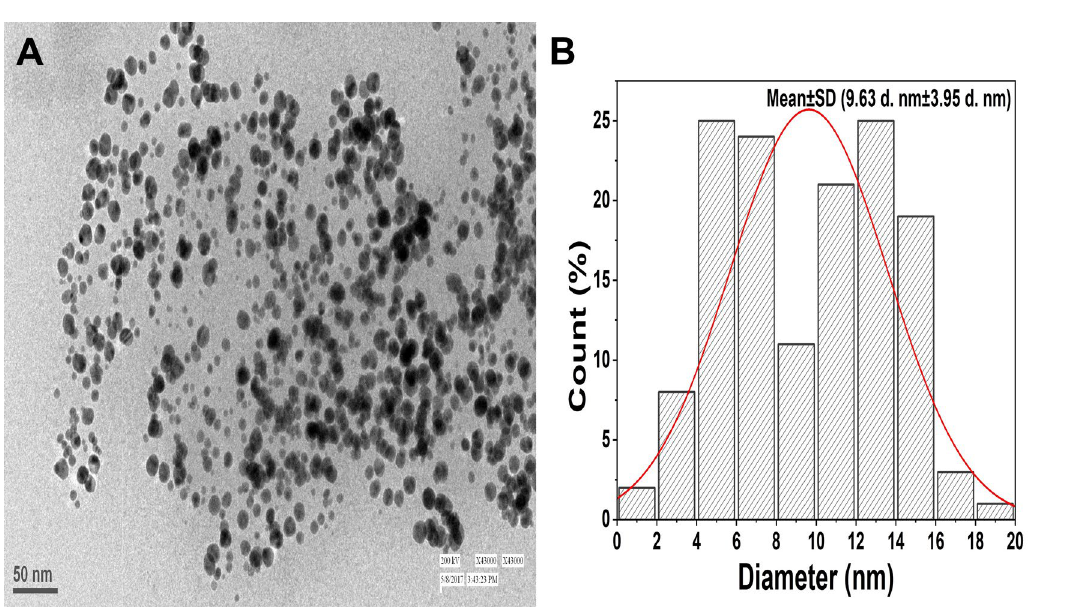
Figure 2. ( A ) TEM micrograph generated for the original sample of the 2 mM Au–Pd BNPs synthesized after the addition of 10% aqueous leaf extract of Citrus limon ; ( B ) Particle size distribution histogram plot generated from the size measurement data obtained by the ImageJ analysis of the nanoparticles observed in the TEM micrograph ( A